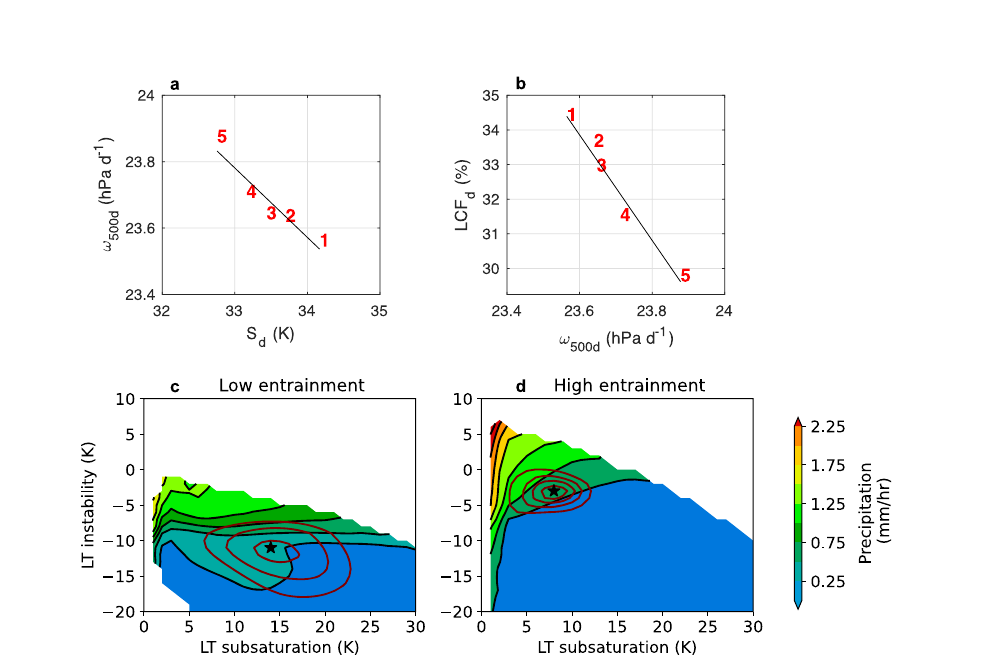
Fig. 8 | Higher entrainment rates lead to weaker static stability, stronger subsidence, and fewer low clouds than lower entrainment rates. The relation- shipsbetween( a )thedescentregionpressurevelocityat500hPa( ω 500d ;hPaday − 1 ) and the descent region staticstability (S d ; K)and ( b ) ω 500d and the descent region lowcloudfraction(LCF d ;%)amongaCAM5.3perturbedphysicsensembleinwhich entrainment was perturbed from low to high rates: (1) 0.08km − 1 (2) 0.16km − 1 , (3) 0.25km − 1 , (4) 0.5km − 1 , and (5) 1.5km − 1 . Each value is an average of monthly mean output from a single 11-year run from 1995 – 2005. All relationships shown are tro- pical averages (30°S-30°N) including both land and oceanpoints. The output used